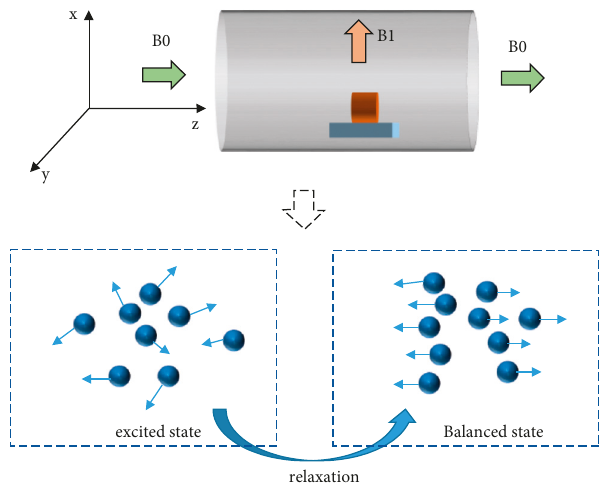
Figure 4: Schematic diagram of relaxation